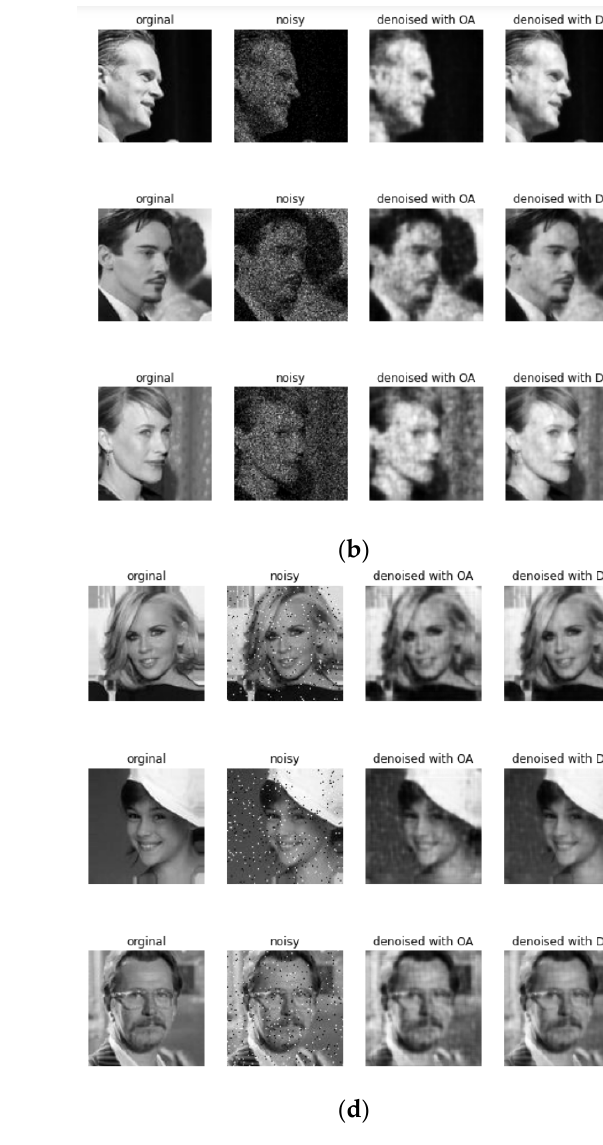
Figure 13. Original image [68–71], noisy image, and images restored by one and dual autoencoders with separable convolutional neural networks under ( a ) Gaussian noise, ( b ) Poisson noise, ( c ) speckle noise, and ( d ) impulse noise.